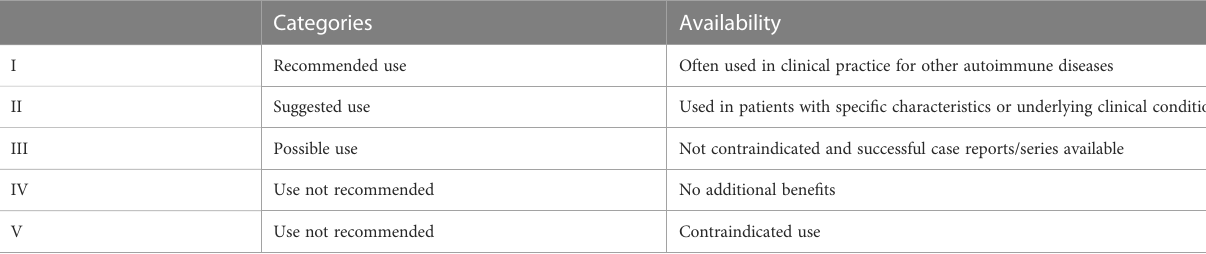
TABLE 1 Guidance for off-label use of biological therapy.